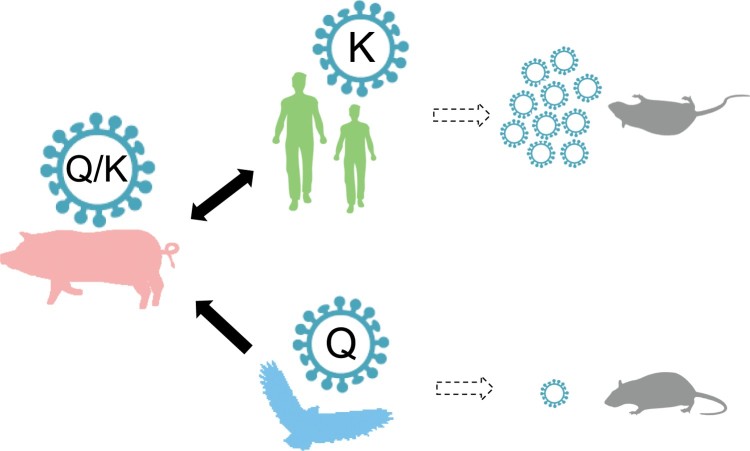
Conceptual model of the generalized inferred evolutionary pathways and virulence outcomes of NP-Q357K in influenza A viruses. Avian influenza viruses carrying NP-357Q were transmitted to pigs. The Q357K substitution was introduced into the NP protein during the adaptation of the avian influenza virus to swine. Mutants with NP-357K were selected, then transmitted to and circulated in humans. The Q357K substitution alters the viral phenotype in mice.